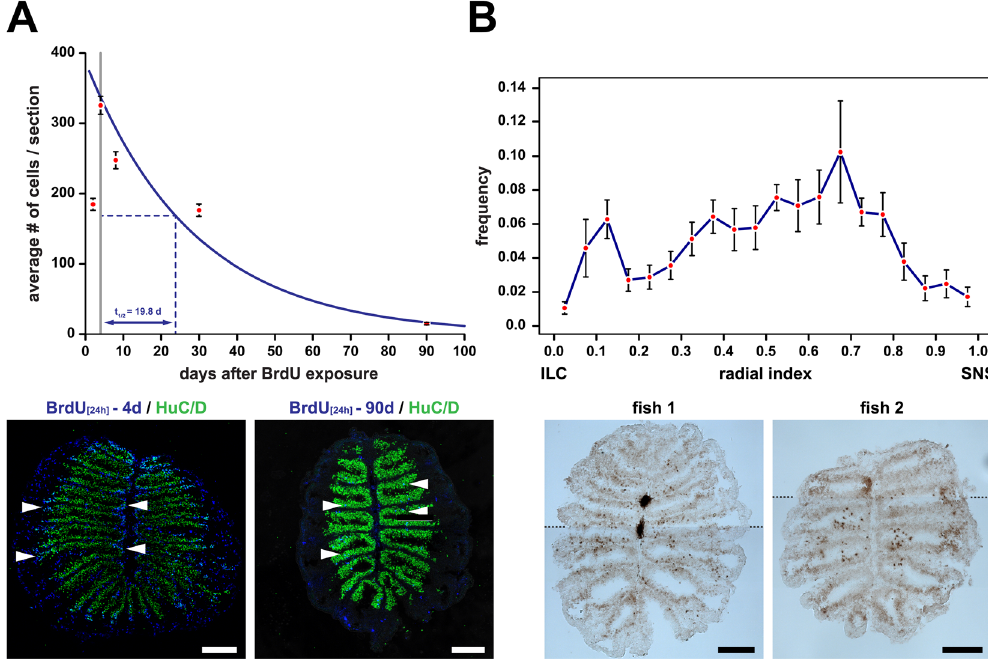
Figure 7. Cell death in the zebrafish OE. ( A ) Immunohistochemistry against BrdU and HuC/D and survival curve of BrdU/HuC double-positive OSNs (top; mean ± SEM; top) following 24 h incubation with BrdU. The data points after the initial increase of double positive cells between 2d and 4d can be fitted with the exponential function #cells = 387.5e − 0.035 X , which corresponds to an OSN half life of t 1/2 = 19.8 d. (n = 2d: 17, 4d: 26, 8d: 18, 30d: 51, and 90d: 60 sections). Representative cross sections for the 4d (left) and 90d (right) time point are shown (bottom). BrdU/HuC double-positive cells (turquoise, arrowheads) are more numerous at earlier time points and undergo positional shifts towards the centre of the sensory OE. ( B ) Detection of cell death in the adult zebrafish OE by terminal deoxynucleotidyl transferase dUTP nick end labeling (TUNEL) of fragmented DNA on cross sections though the OEs of two different zebrafish (bottom). TUNEL-positive cells appear dark brown by chromogenic detection with 3,3 ′ -diaminobenzidine. The images represent composites of two high-resolution pictures joined together at indicated positions (dotted lines) to cover the full sections. The frequency distribution of TUNEL-positive cells along the radial dimension of the sensory region of the OE is shown in the top graph. The position of cells has been normalized to the distance of the sensory/nonsensory border (SNS) from the tip of the interlamellar curve (ILC). TUNEL-positive cells can be found throughout the entire sensory OE but are unevenly distributed and more abundant in the vicinity of the ILC and in the centre of the sensory OE. The data points represent the means ± SEM of the distribution of 689 cells from 9 sections of 3 fish. Scale bars: 100 µ